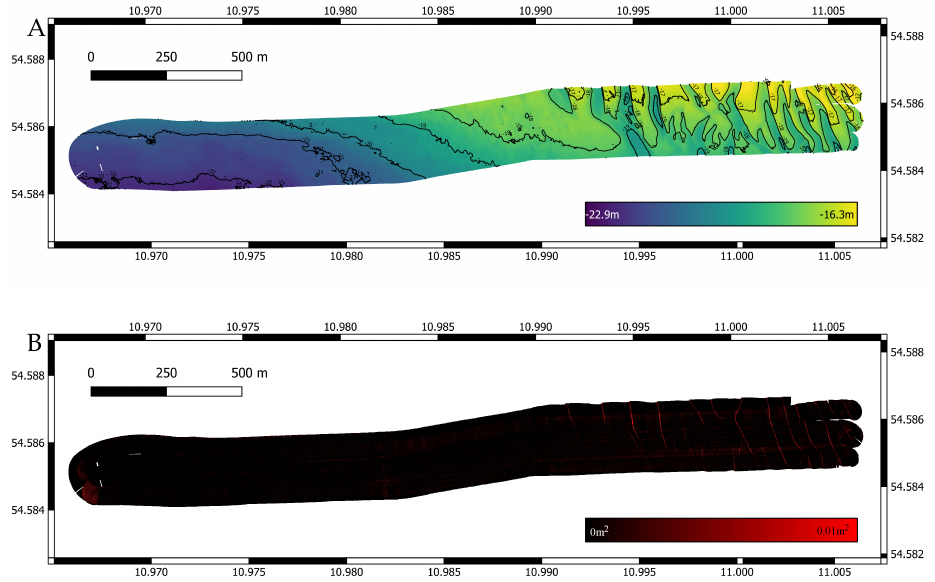
Figure 5. Survey with original navigation. ( A ) Bathymetric map with a cell size of 0.5 m. ( B ) Variance for the same grid cells. As expected the variance is reasonably low. In certain areas, a minimal increase can be observed, which is due to slightly mismatched heights between individual tracks. A navigation drift is not the cause, which can be further validated by a visual inspection of features like rocks, which match